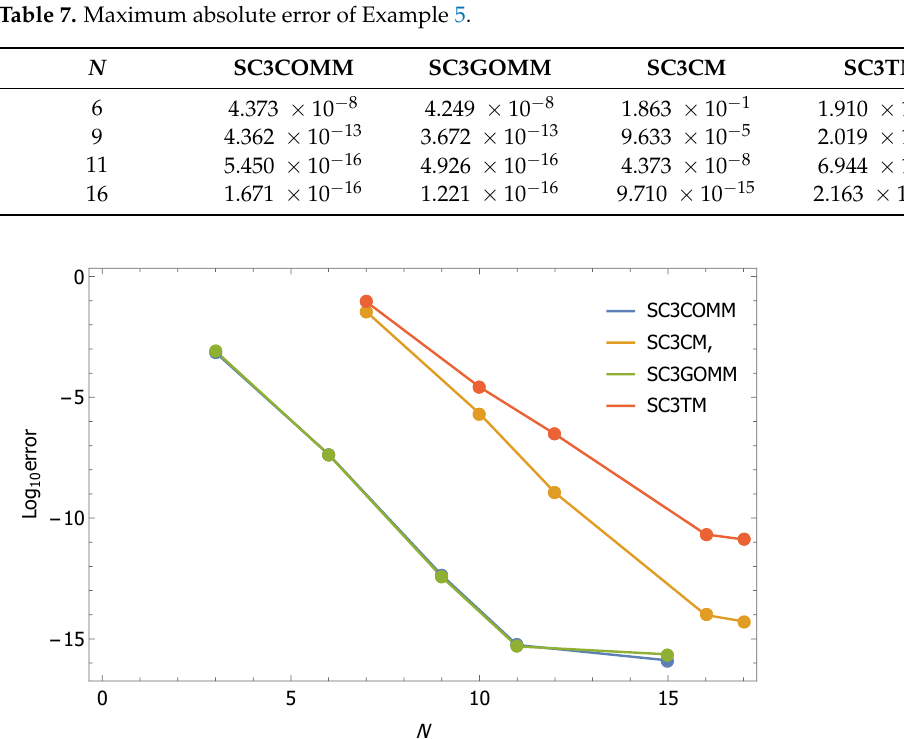
Figure 3. Comparison between the errors of Example 5 for N = 3,4, . . .